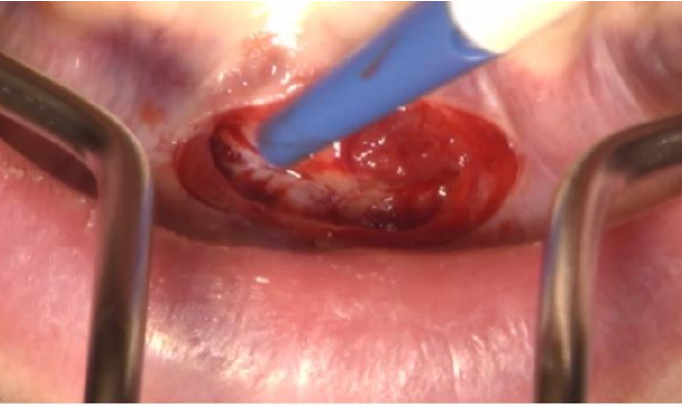
Figure 3. Trapezoidal incision in region 42 to 32 apical of the affected teeth for the Partsch II cystectomy one week after the first appointment.